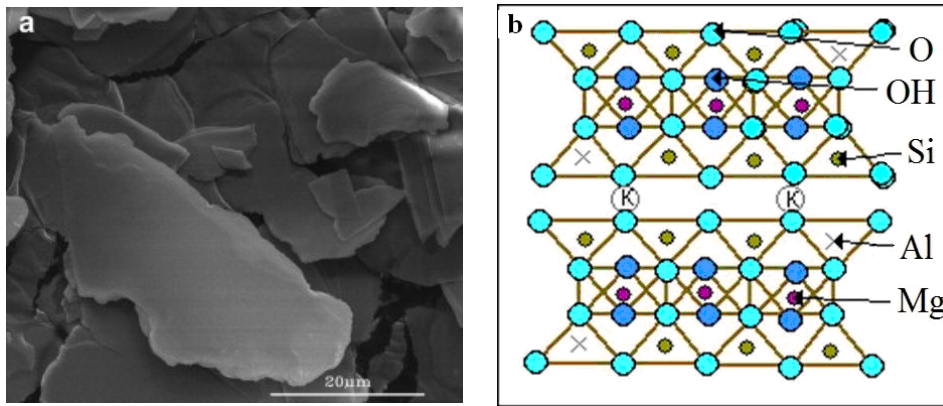
Figure 3. Phlogopite: ( a ) SEM images of mica particles; ( b ) crystal structure of mineral.